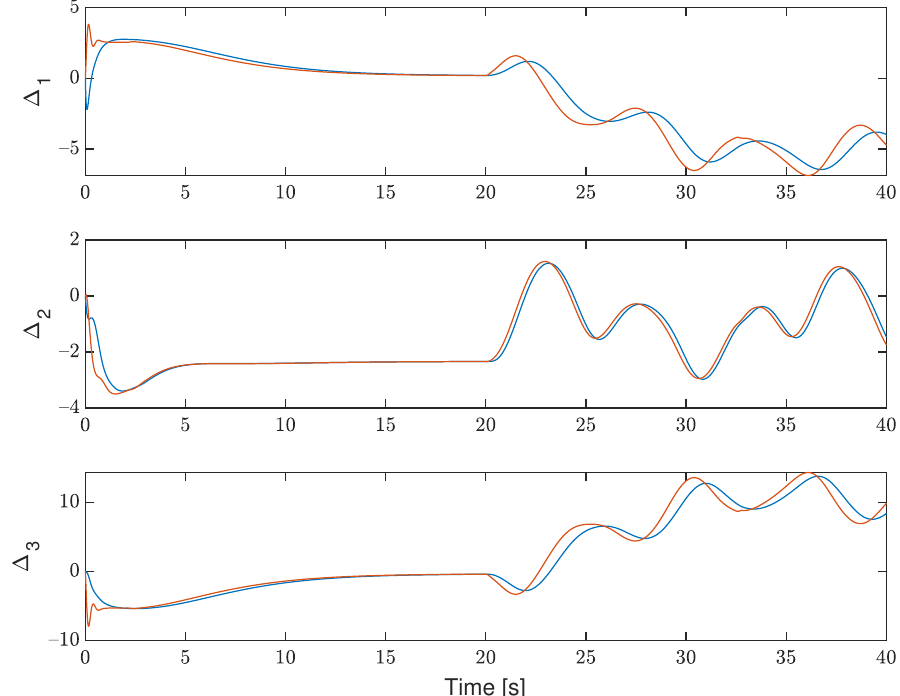
Figure 8. Disturbance estimates (blue) vs. their true values